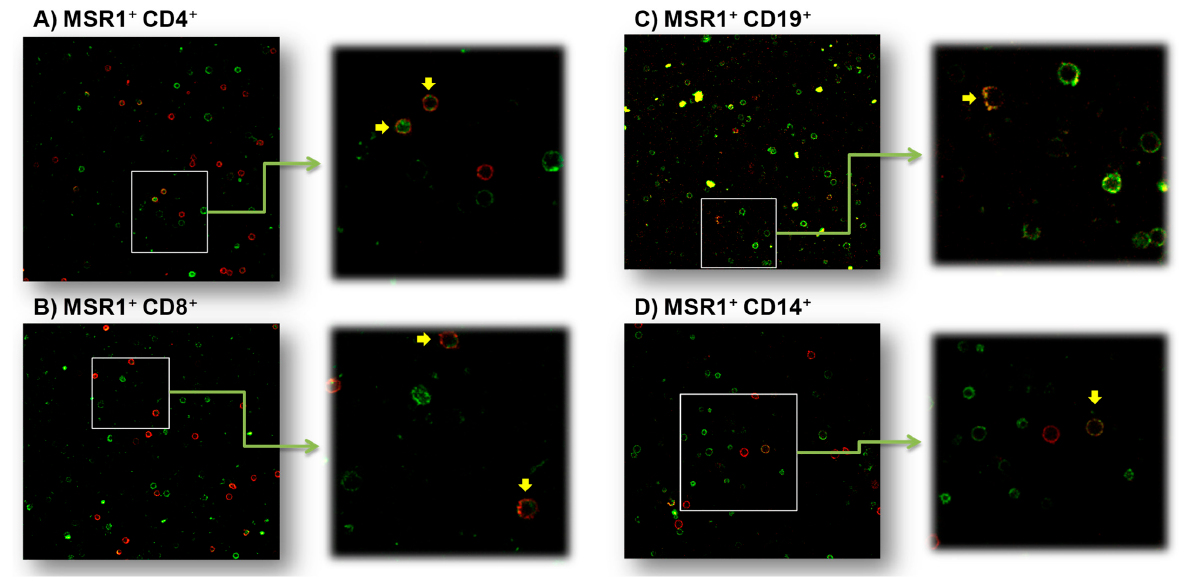
Figure 2. Representative example of PBMCs marked with fluorescence for the subpopulations: ( A ) CD4 + , ( B ) CD8 + , ( C ) CD19 + , and ( D ) CD14 + and the MSR1 protein. Confocal microscopy visualiza- tion ( n = 3). Images on the left were obtained with a 40× objective, and those on the right, with 2× zoom. MSR1 + cells are labeled in green, each labeled cellular subpopulation is indicated in red, and the colocalization of the corresponding cellular subpopulation and MSR1 + is marked in yellow. The yellow arrows indicate cells with double labeling.